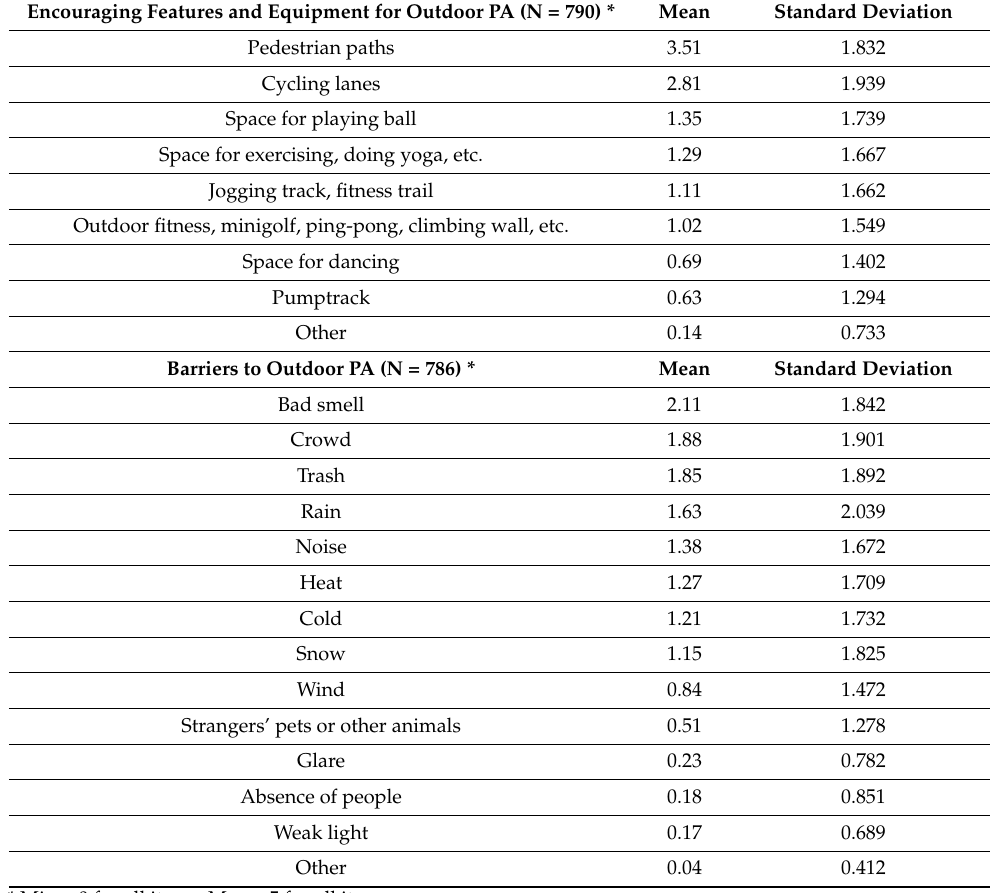
Table 3. Encouraging Elements and Barriers for Outdoor Physical Activity.